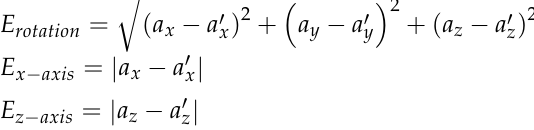
Figure 4. The performance of numerical stability for our proposed method (red), P3P solver (black), and RPnP solver (blue). ( a ) Distribution of the total rotation error; ( b ) distribution of the rotation error around the X ‐ axis; ( c ) distribution of the rotation error around the Z ‐ axis. From Figure 4, the log 10 of the total rotation error, and the rotation error around the X ‐ axis and Z ‐ axis are observed clearly. It can be seen that our proposed method has the best performance for numerical stability, and P3P solver and RPnP solver perform similarly, but both are worse than our proposed method. 3.1.3. Noise Sensitivity Noise might come from the 2D point/line in the image and 3D point/line in the world frame. If the noise of the 3D point/line exists, it could be responding in the image reprojection through the camera imaging model, and thus we can say that the noise of the